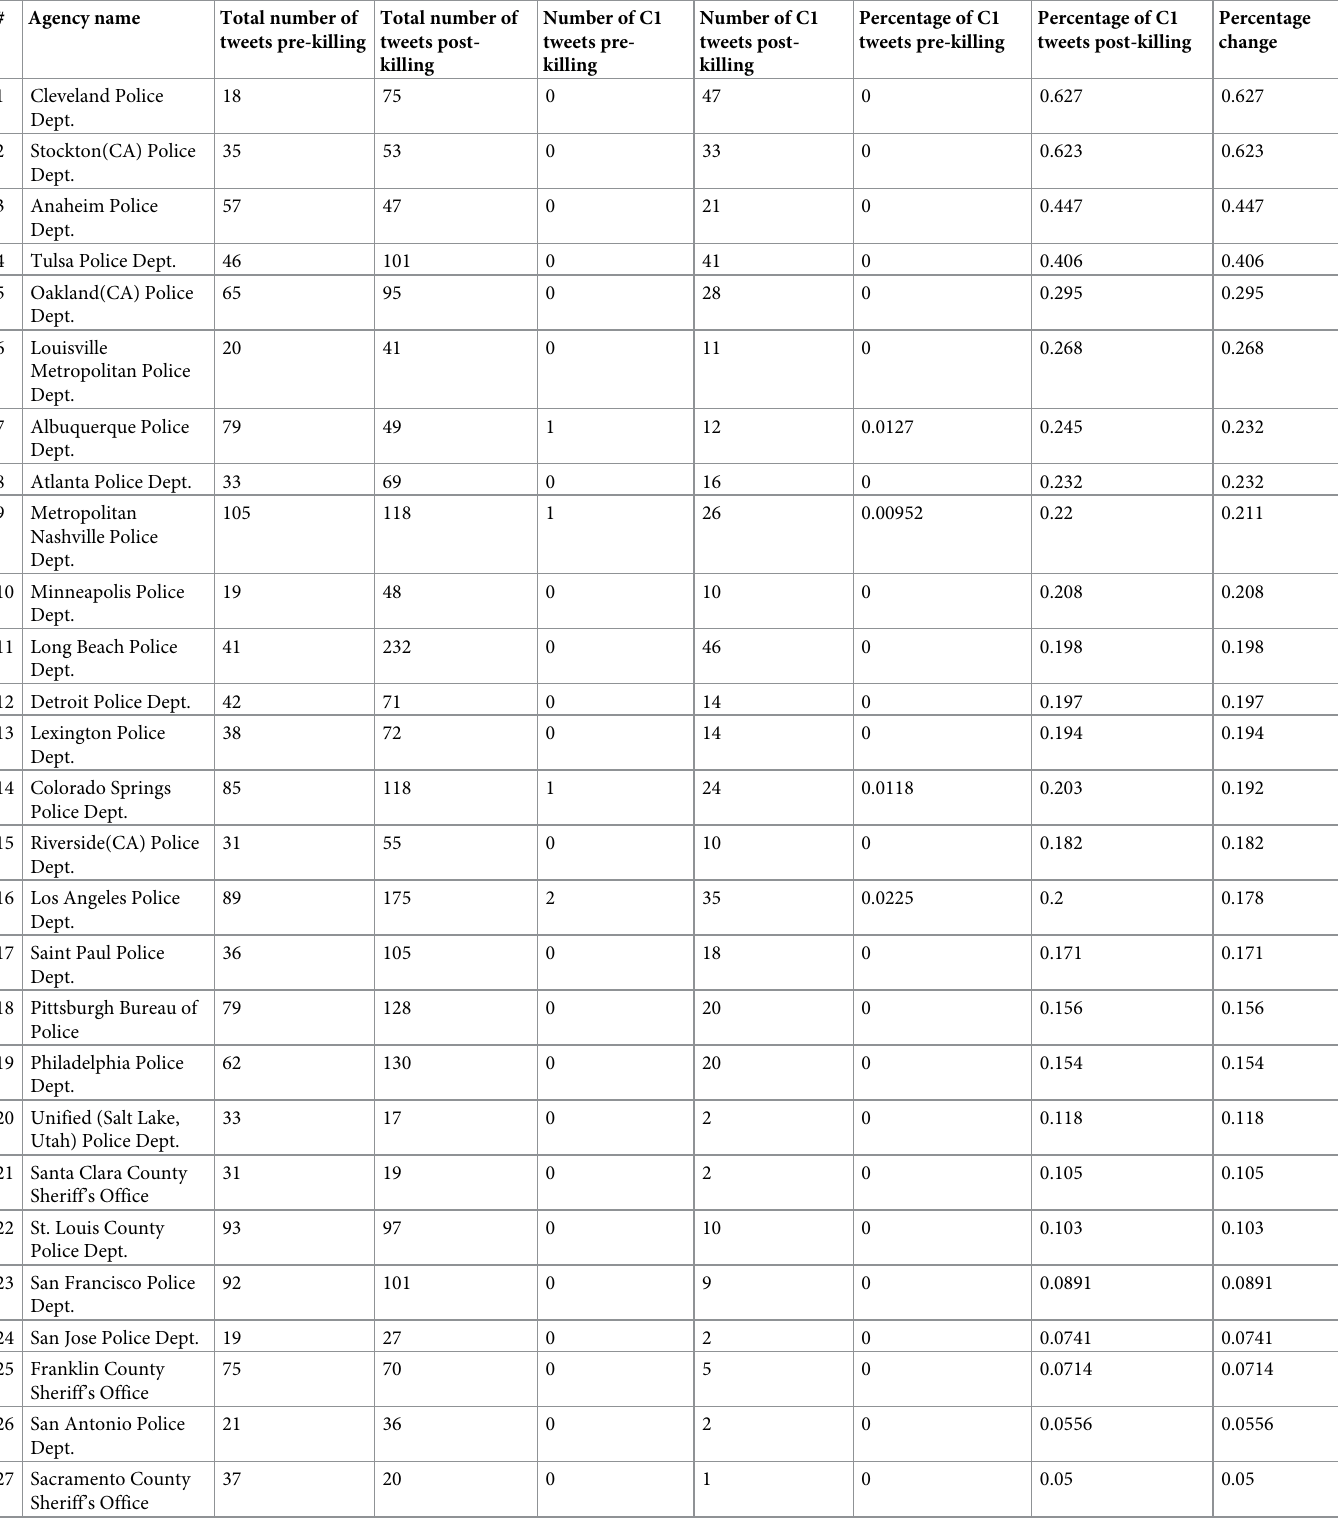
Table 10. Agencies (in the lower-use group) ranked by the increase in posting category 1 (civil unrest related) tweets before and after the killing. # Agency